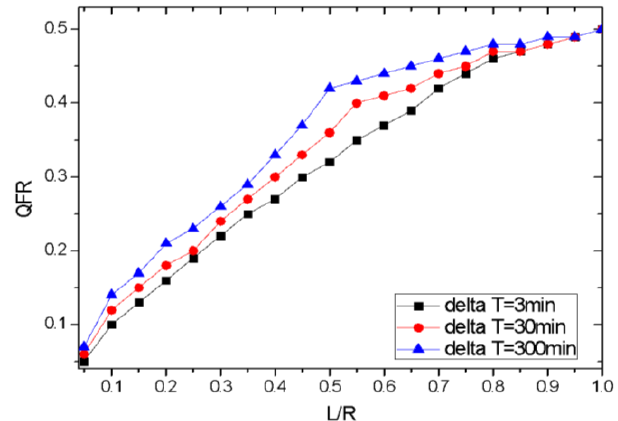
Figure 8. Query failure rate (QFR) compared to the rate of AMS local cache size to remote AID numbers (L/R).